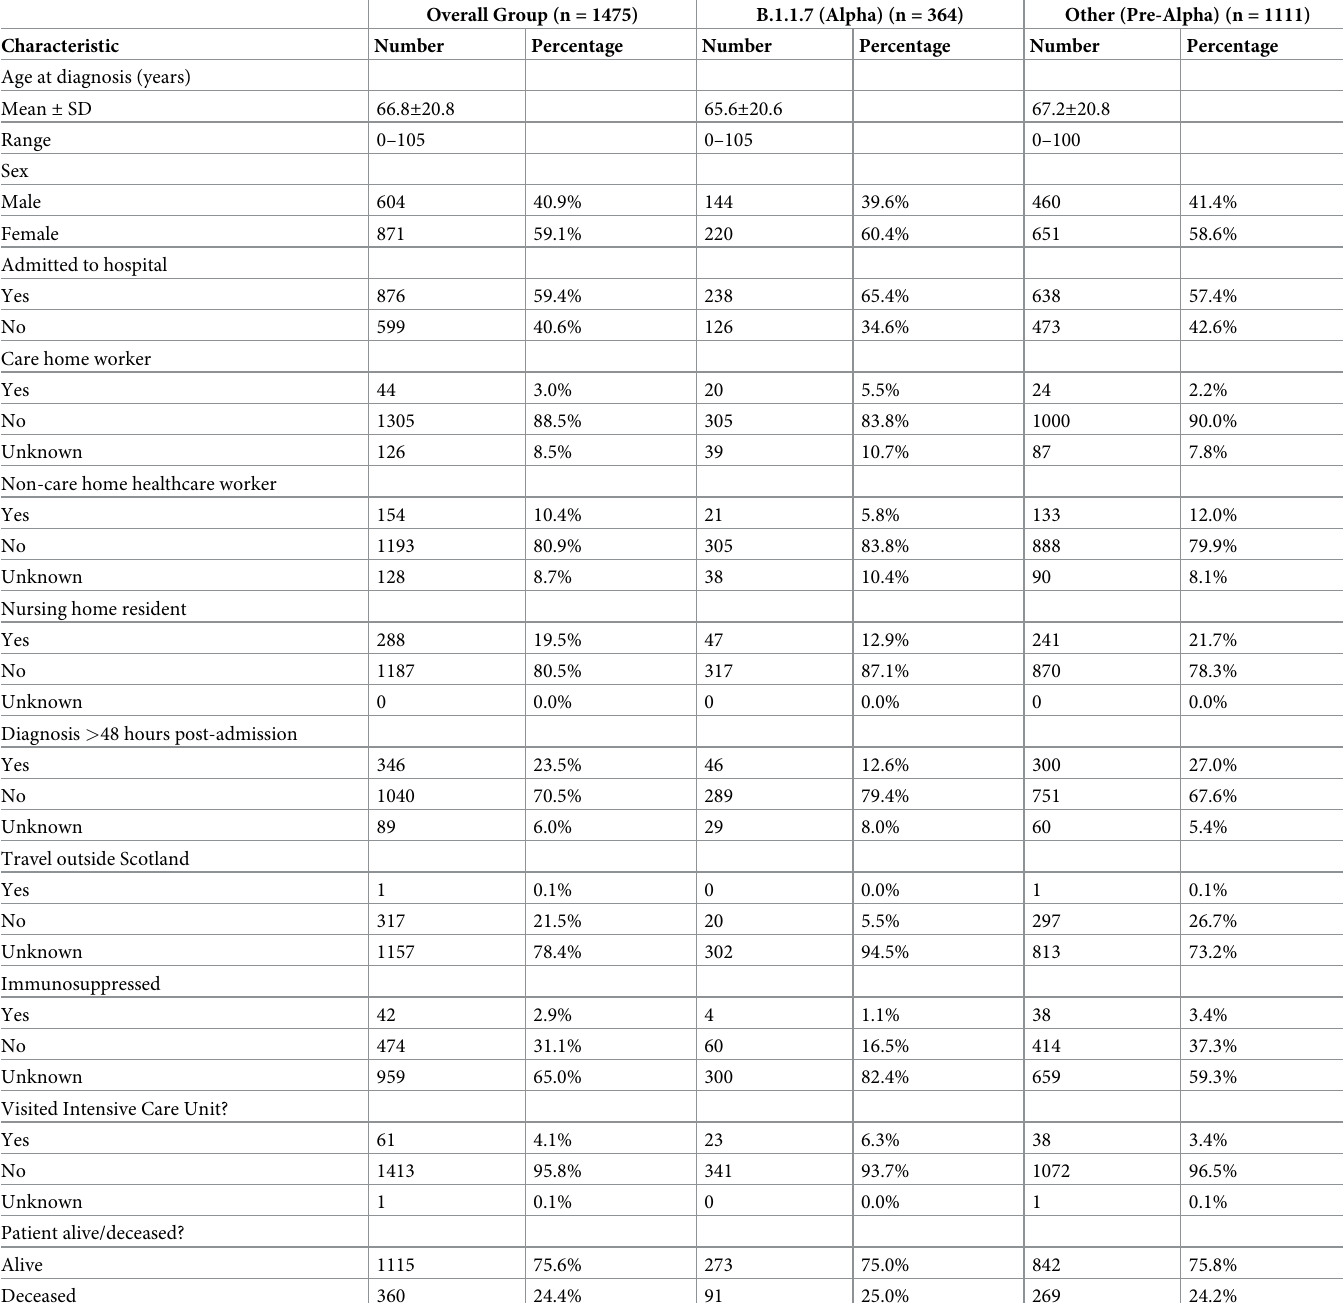
Table 1. Demographic characteristics of Scottish patients infected with SARS-CoV-2 by